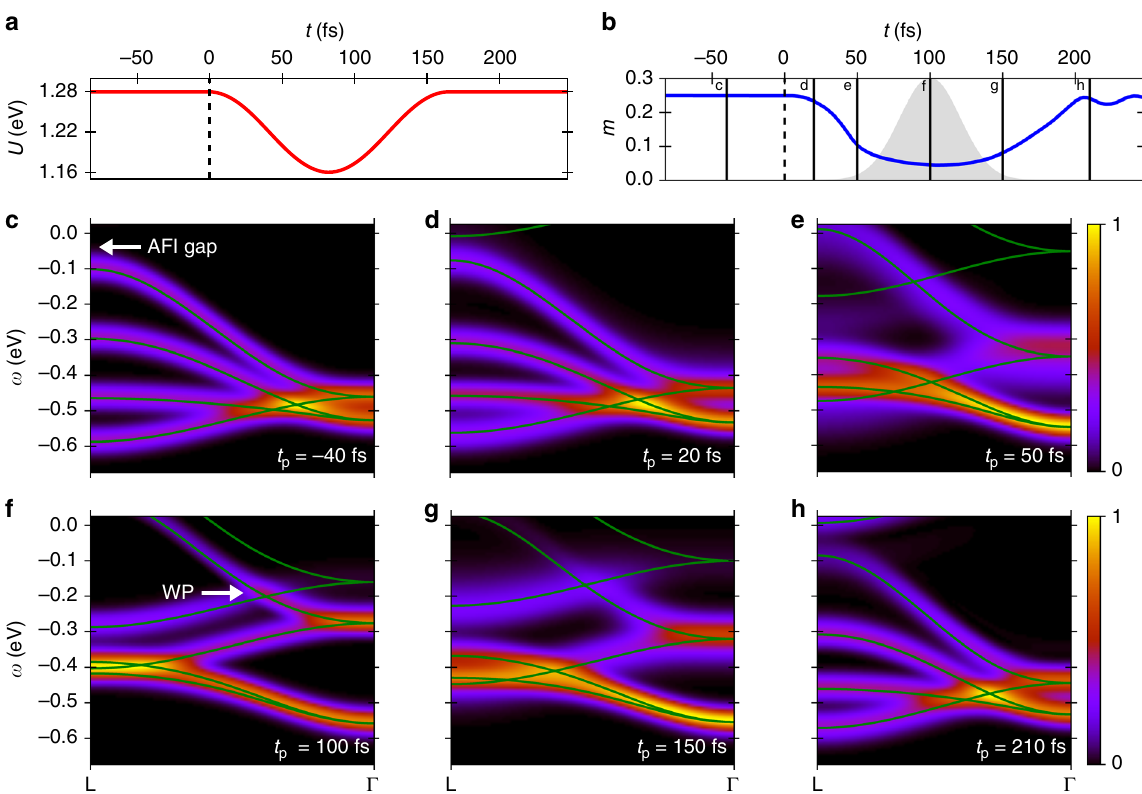
Fig. 4 Relaxation of nonthermal Weyl semimetal. a Time-dependent interaction relaxing back to the initial value, U (0 ≤ t ≤ 150 fs) = U i − ( U i − U q ) sin( π · t / 150 fs). b Corresponding time evolution of the magnetisation. As in the instantaneous case, the magnetisation is initially reduced before slowly relaxing back towards its initial value. The vertical solid lines indicate the probe times t p for which the tr-ARPES signals are shown in c – h , with a probe pulse duration σ p = 20.6 fs indicated by the grey-shaded Gaussian envelope for one selected probe time. c – h Tr-ARPES signals at different probe times (indicated in b ) along L − Γ . The solid lines correspond to the effective band structures of the time-dependent Hamiltonian averaged over the FWHM of the probe the system Hamiltonian. The Hermitian coef fi cient matrix γ αβ is de fi ned by the D E R þ1 Fourier transform of the bath correlation functions d s e i ω ð t Þ s B y α ð s Þ B β ð 0 Þ . (cid:2)1 For every band a and momentum k we de fi ne two system coupling operators d t Þ and A a ; k d y t Þ , which annihilate and create a quasi-particle with A a ; k a ; k ð a ; k ð 1 (cid:4) 2 (cid:4)